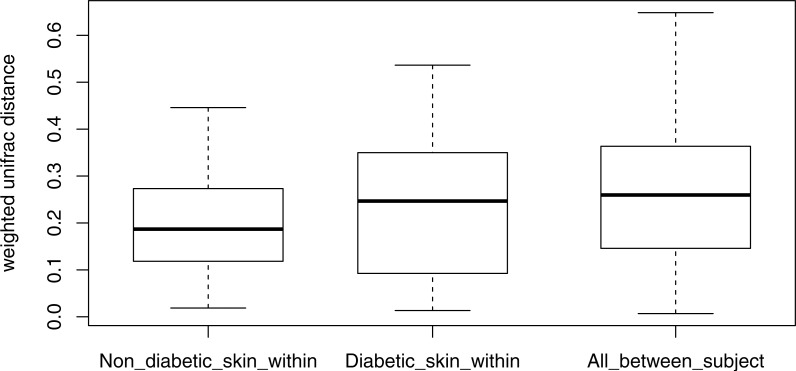
Boxplots of intra-individual differences over time in diabetic and non-diabetic skin microbial communities.Inter-individual distances are also shown for comparison. The stability of non-diabetic skin was higher (i.e., lower distances over time) than for diabetic skin, however this difference did not reach significance. (Kolmogorov–Smirnov test, p = 0.09).